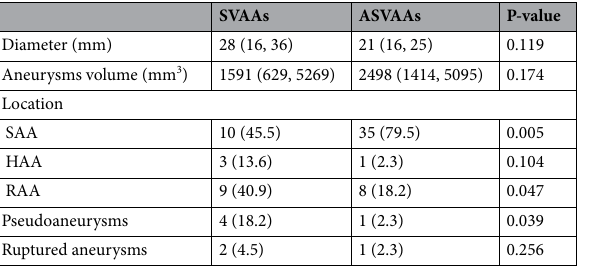
Table 2. Aneurysm characteristics between symptomatic visceral artery aneurysm (SVAA) and asymptomatic visceral artery aneurysm (ASVAA) groups. SAA splenic artery aneurysm, HAA hepatic artery aneurysm, RAA renal artery aneurysm.